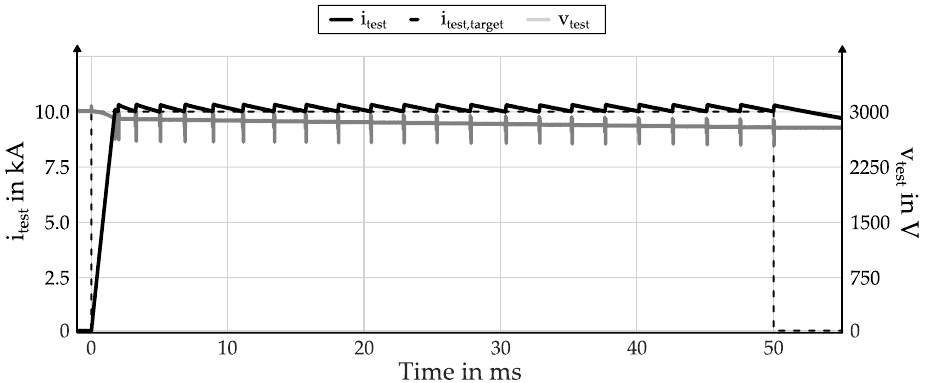
Figure 16. Experimental results for exemplary test current ( I test ) generation (continuous black) with target current amplitude of I test,target = 10.0 kA (dashed black) at an initial source voltage of V test = 3.0 kV (continuous grey).